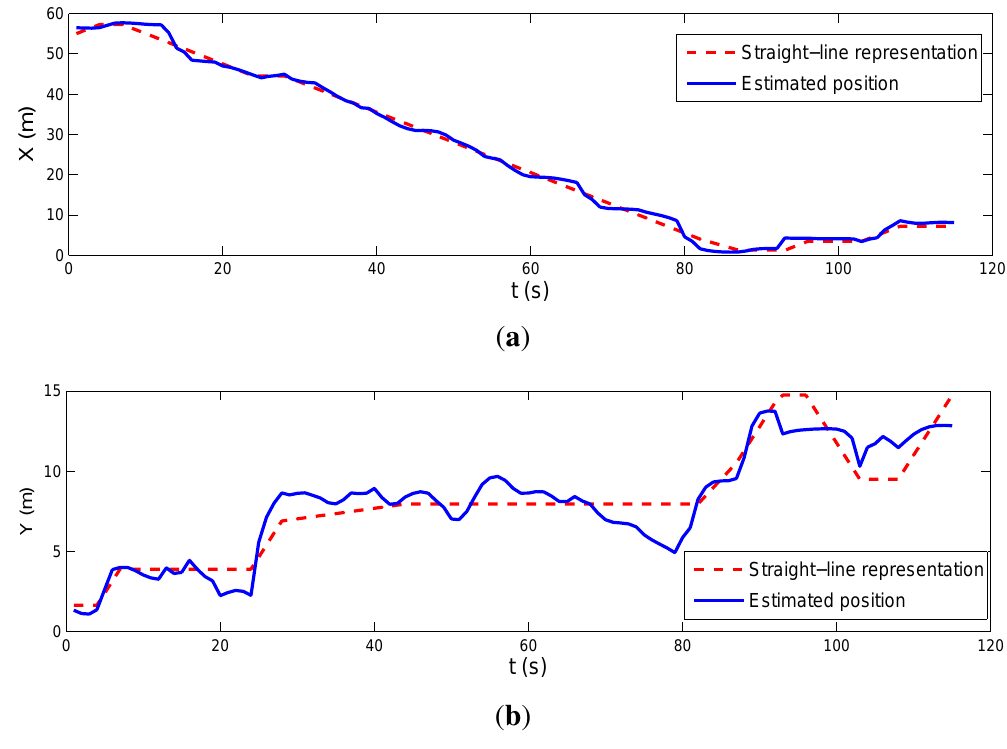
Figure 15. Locations in X (up) and Y (bottom) axes of FIREMAN2 location estimated by the proposed method while its Escape Guiding Functionality was active. The straight-line representation (dashed line) and the actual trajectory followed by FIREMAN2 (solid line) are